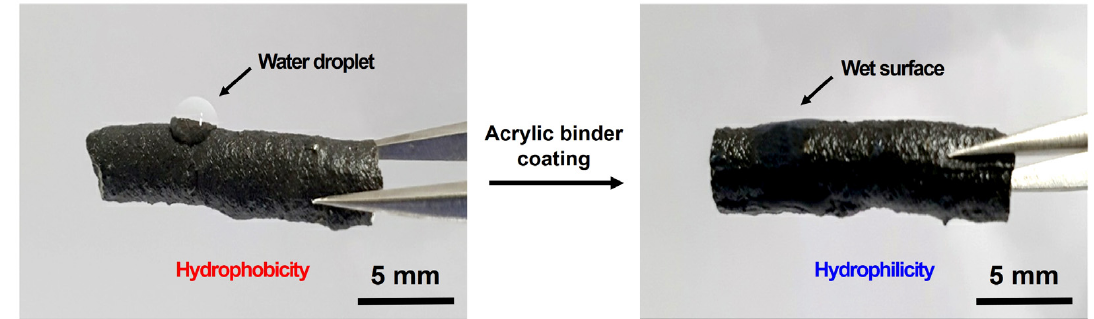
Figure 9. Photograph of the recycled plastic film-based aggregate before and after acrylic binder coating treatment. After treatment, an increase in hydrophilicity is observed.